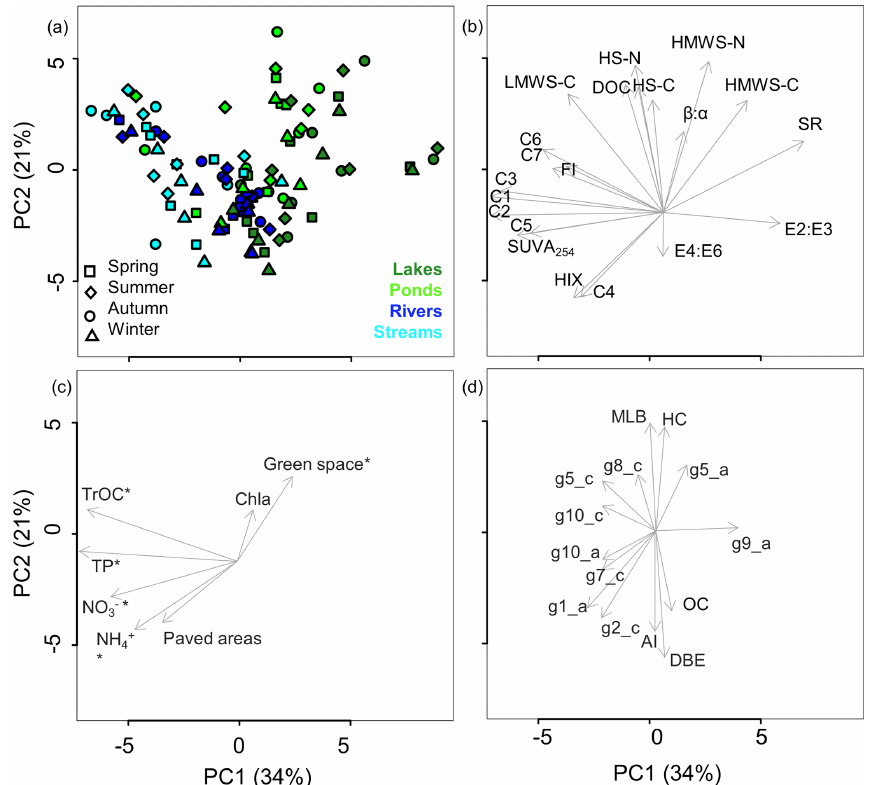
Figure 2. Ordination of sites (a) by PCA based on DOM characteristics (b) : (i) indices derived from measurements of absorbance (E2:E3 indicating molecular size, E4:E6 representing the humification ratio, the slope ratio SR and SUVA 254 ) and fluorescence (freshness index β/α , fluorescence index FI, and humification index HIX), (ii) PARAFAC components C1 to C7, and (iii) data from size-exclusion chro- matography (humic-like substances HS, high-molecular-weight non-humic substances HMWS, low-molecular-weight substances LMWS). (c) Potential drivers of DOM composition, which were used as constraints in the RDA, mapped onto the PCA ordination, with the significant constraints marked by an asterisk ( ∗ ). (d) FT-ICR-MS-derived indices and molecular groups mapped onto the PCA ordination representing only groups correlated with PC1 or PC2 ( r > 0 . 2; oxygen richness O:C; saturation level indicated by H:C; double-bond equivalents DBE; aromaticity index AI; molecular lability boundary MLB; molecular groups g1 and g2 indicating black carbon without and with heteroatoms; g5 consisting of unsaturated aliphatics; g7 representing saturated fatty acids; g8 and g9 denoting carbohydrates without and with heteroatoms N, S or P; and g10 comprising peptides). The molecular group measures are either average masses (marked by “_a”) or counts of molecules (marked by